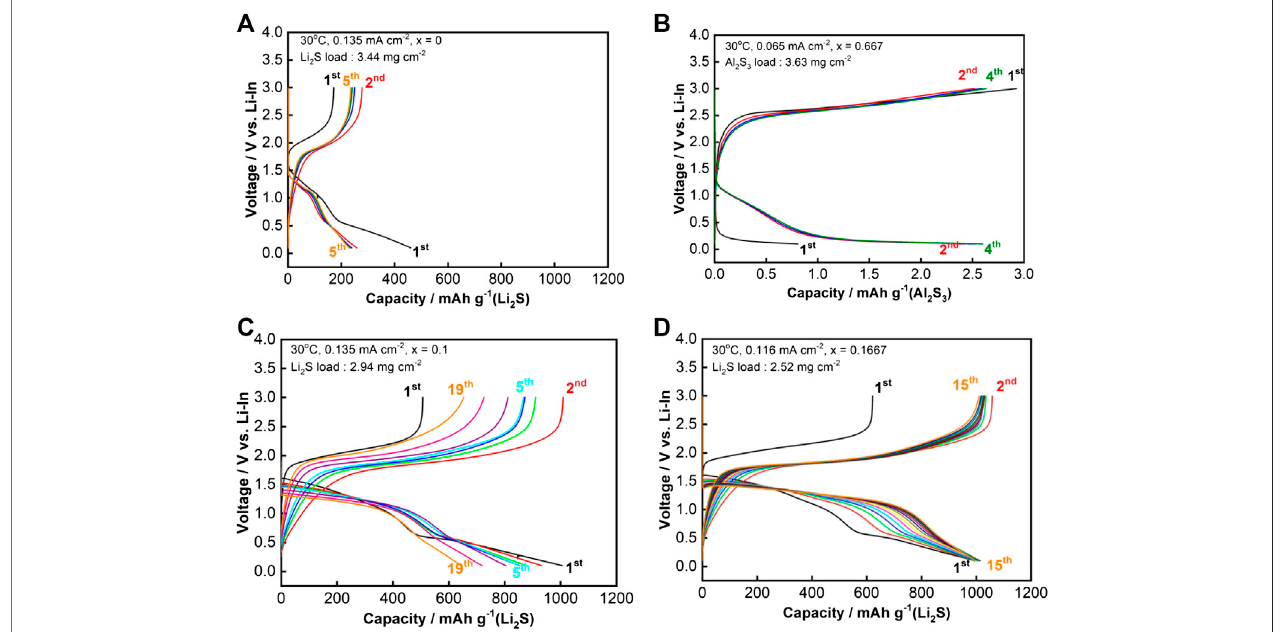
≤ x ≤ 0.1667) cycled at room temperature. (A) x (cid:1) 0 (Li 2-3x Al x S (0